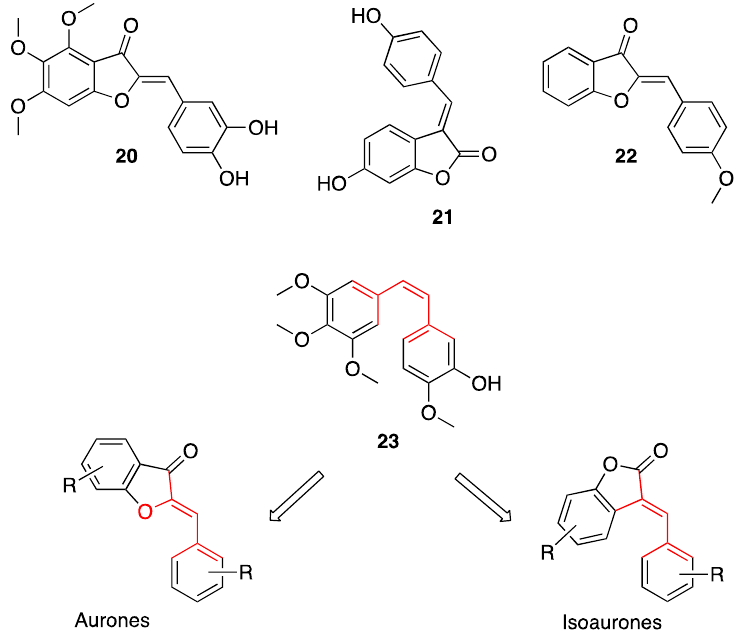
Figure 7. Representative examples of aurones endowed with anti-tumor efficacy.